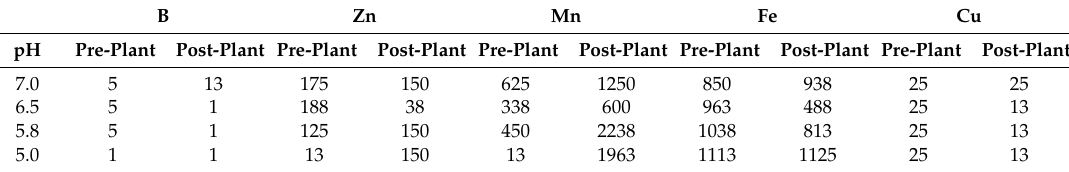
z Solids were dried at 105 ◦ C for 24 h before